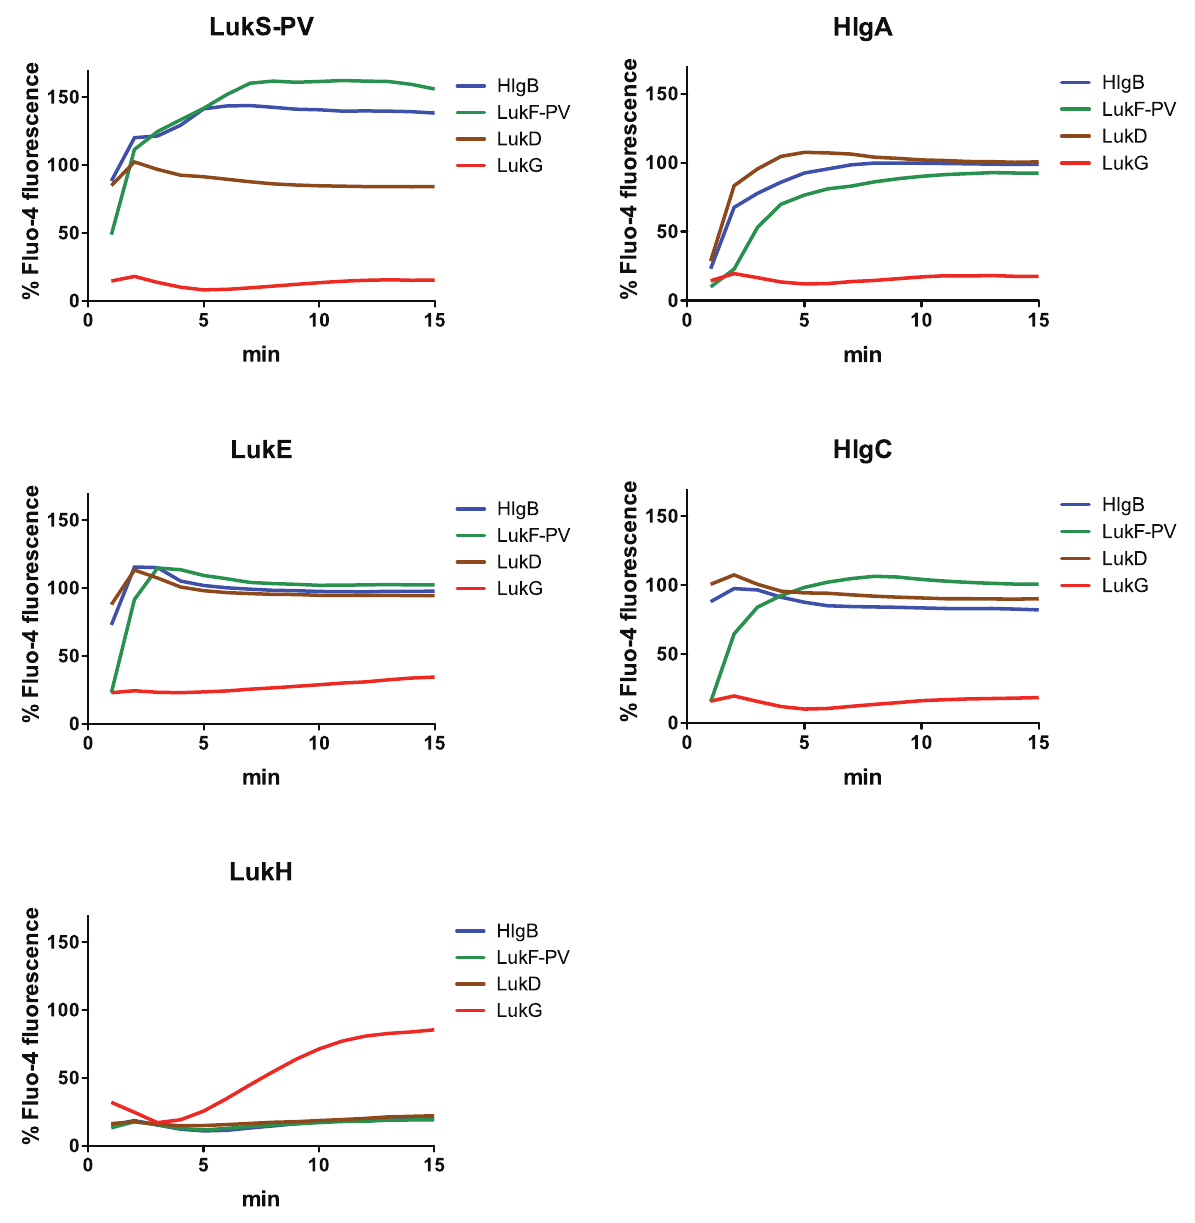
Figure 2. Calcium ion entry into human PMNs by combinations of S and F components from LukGH, PVL, LukDE and c -hemolysin. Calcium flux was determined as described in Figure 1. Each panel shows a particular S component (header) as mixed with various F components (LukG: red, LukF-PV: green, LukD: brown, HlgB: blue). The concentration of all proteins was 500 nM. The results shown are the mean of three independent experiments.